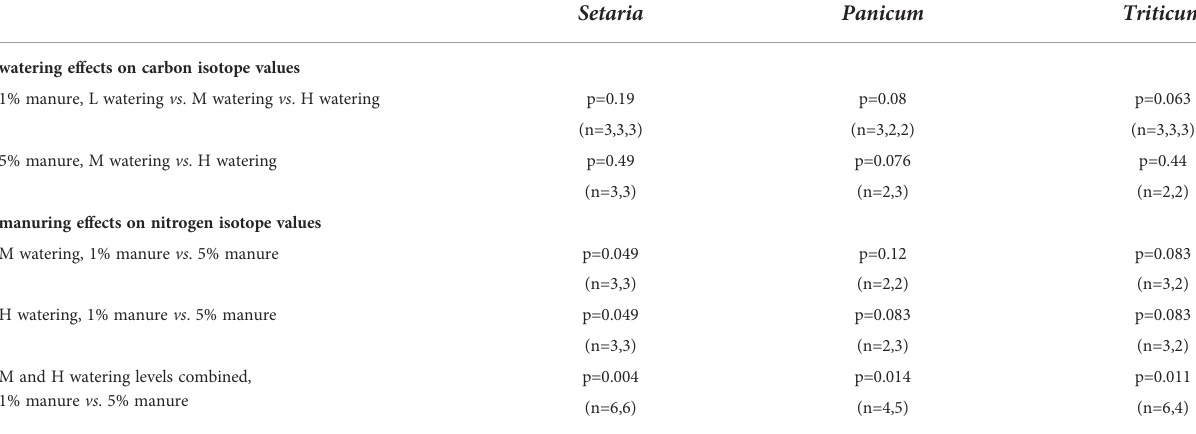
TABLE 3 Kruskal-Wallis test results of watering and manuring effects on the carbon and nitrogen isotope values of foxtail millet ( Setaria ), broomcorn millet ( Panicum ), and wheat ( Triticum ) grains.